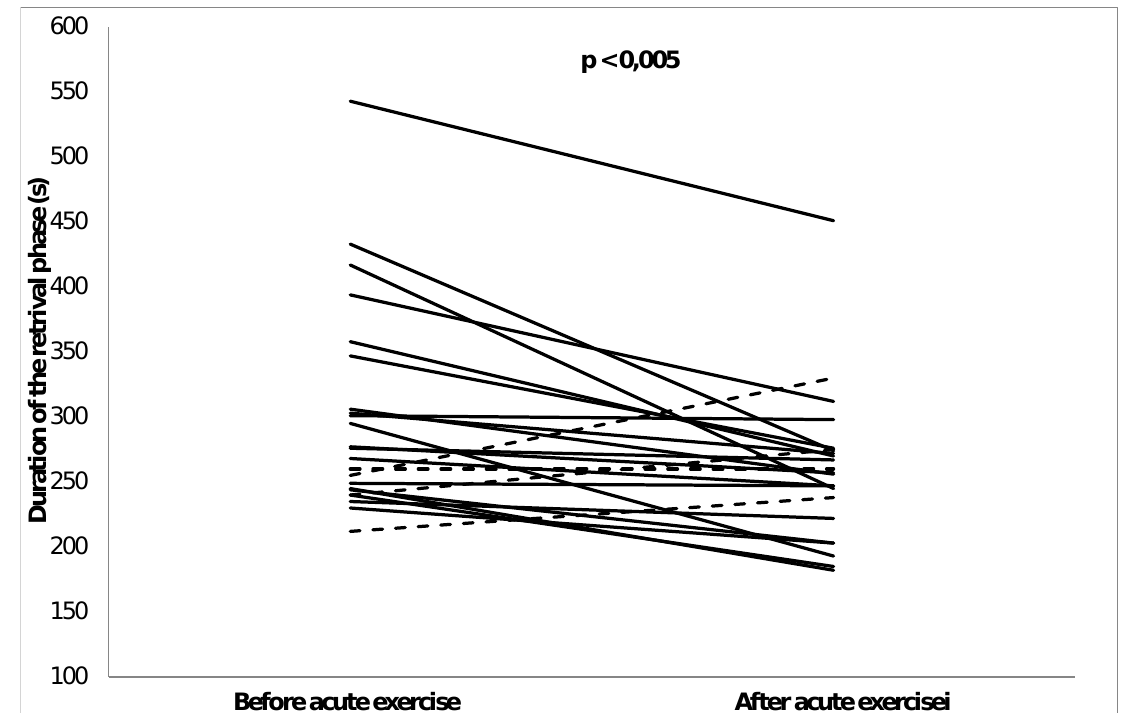
Fig.2. Individual scores in the face/name association test – duration of the retrieval phase. Each subject’s results from before and after acute exercise are connected by a line. Solid line depicts subjects who fared better on the post- exercise test, dashed lines those who fared worse after acute physical